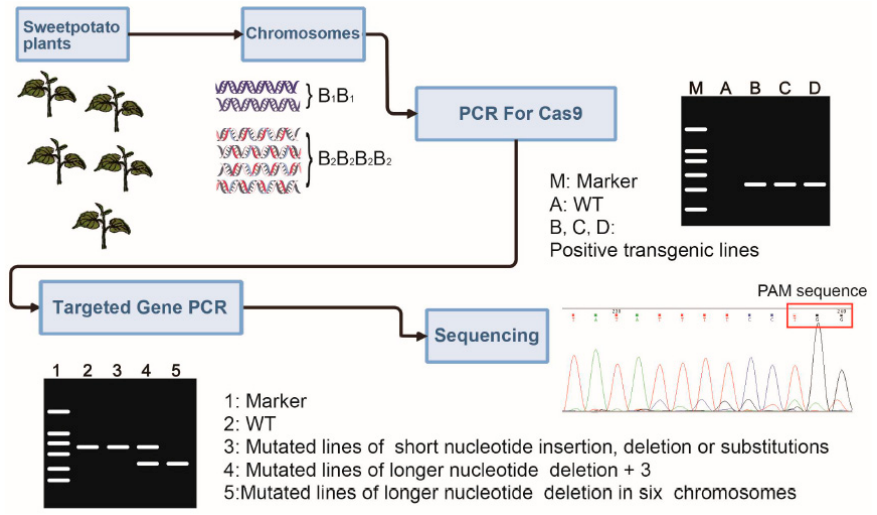
Figure 2. Schematic representation of the workflow designed to analyze targeted gene mutations of CRISPR/Cas9 editing. Transgenic lines were identified by PCR detection of Cas9 genes. Mutation detection in transgenic lines by PCR amplification with primers flanking the sgRNA target sites and running gel electrophoresis to roughly estimate the mutation types. PCR products sequencing analysis was performed by examining their sequencing chromatograms for accurate mutation status.